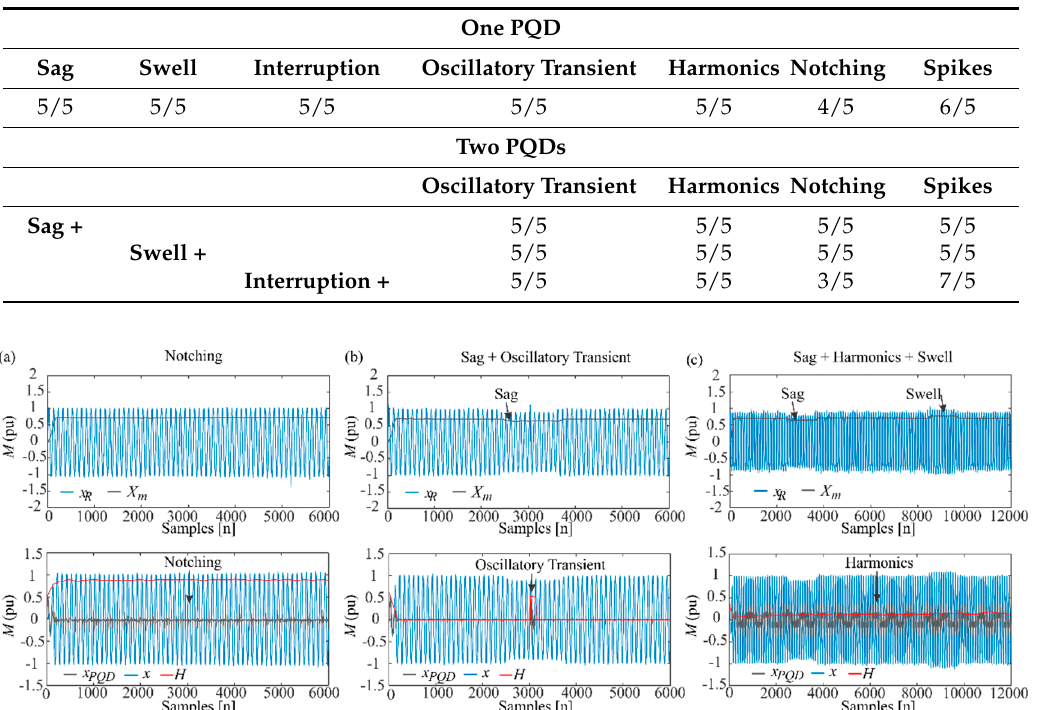
Table 3. Results for real signals.